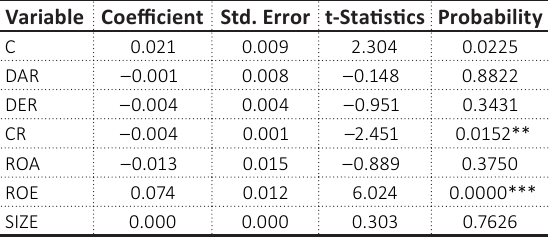
Table 4. Panel data regression output Variable Coefficient Std. Error t-Statistics